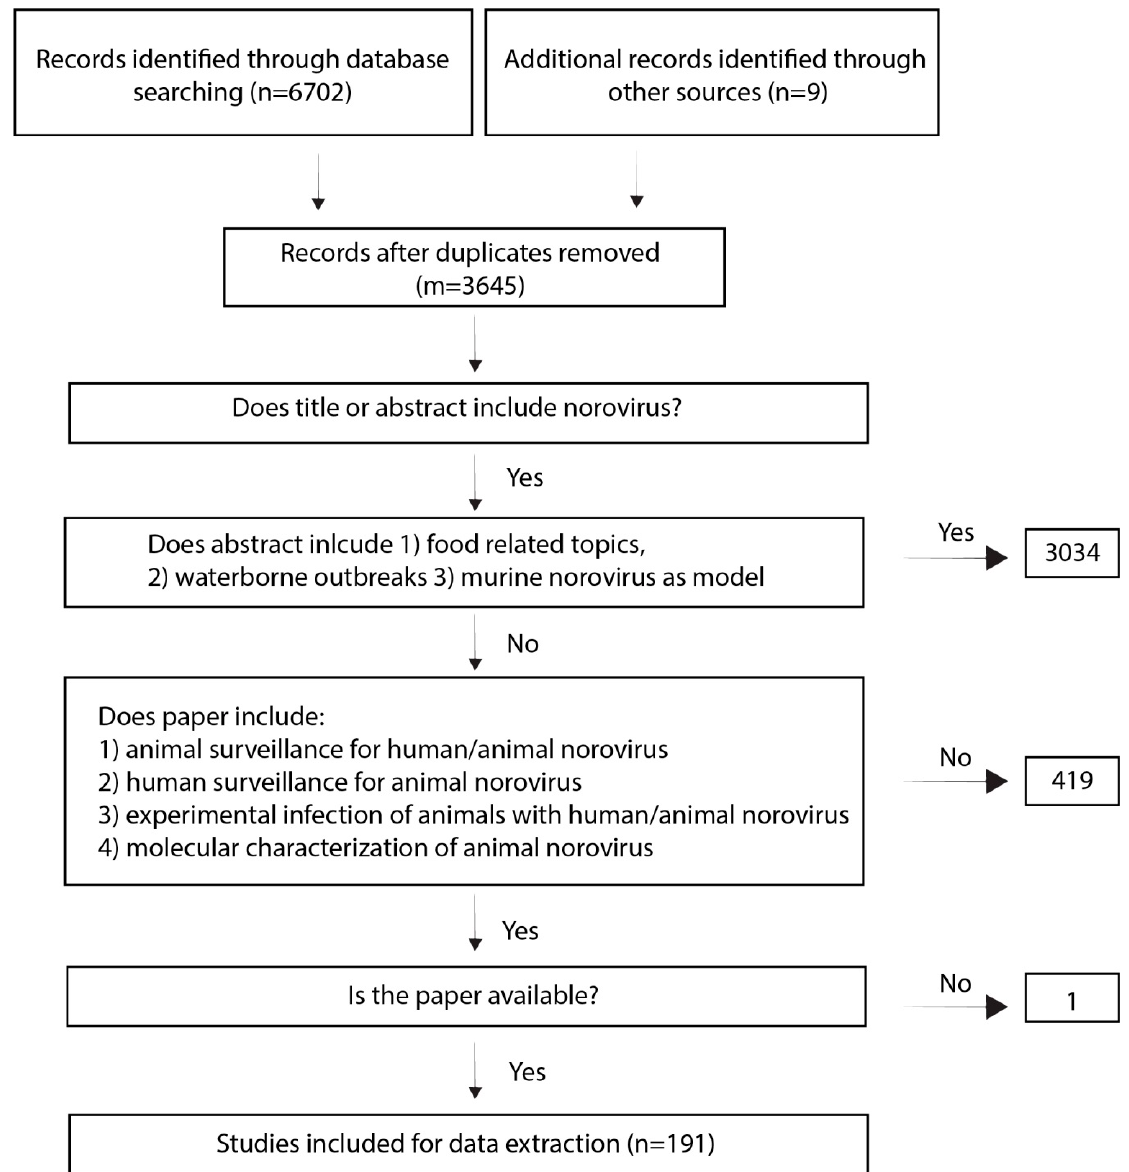
Figure 5. Inclusion and exclusion criteria for paper selection.